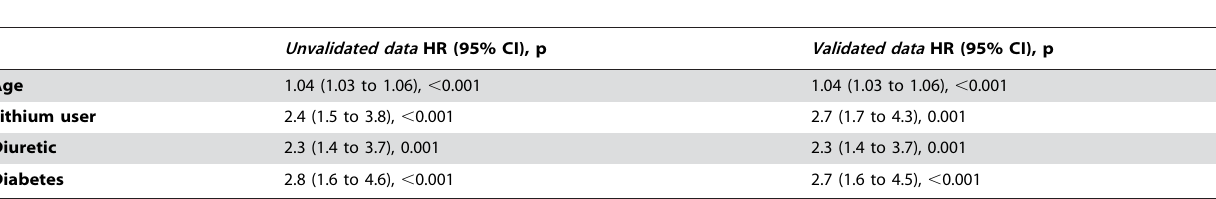
Table 3. Final adjusted hazard ratios for renal failure among lithium and non-lithium users (using validated